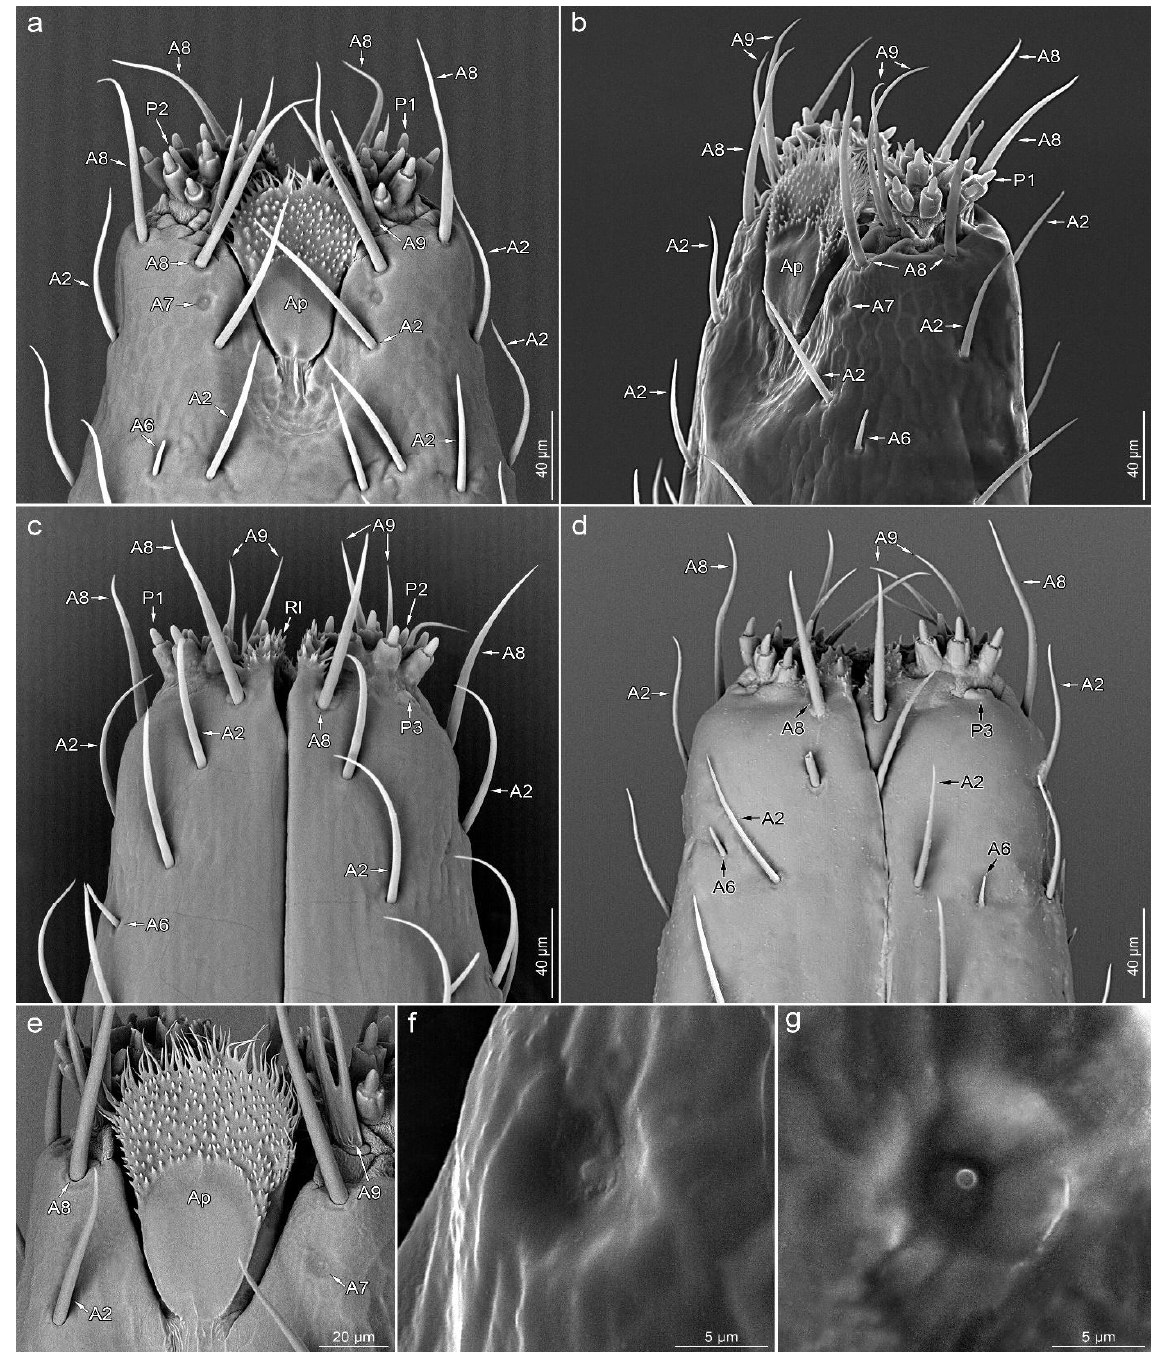
Figure 3. Detailed morphology of labial tip; ventral view ( a ), ventrolateral view ( b ), dorsal view ( c , d ), apical plate ( e ), sensillum type A7 in magnification ( f , g ). Leptoglossus occidentalis ( a – c , e – g ). Leptoglossus zonatus ( d ). Abbreviations: A2, A6–A9, P1–P3—types of sensilla; Ap—apical plate; Rl—rostral lid.